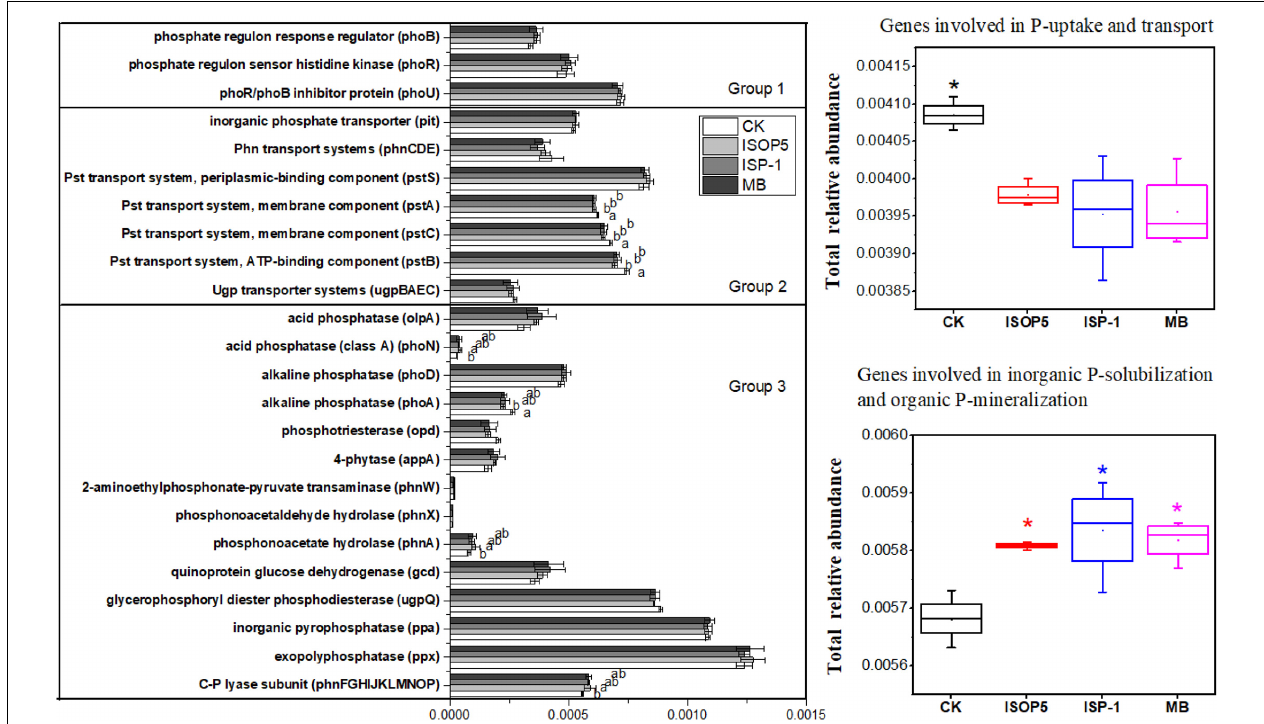
FIGURE 3 | Relative abundance in representative genes responsible for microbial (1) P starvation response regulation, (2) P uptake and transport, and (3) inorganic P solubilization and organic P mineralization in soils treated with or without bacterial inoculums. The relative abundances of genes were calculated based on the annotated reads. Group 1: Genes coding for P starvation response regulation; Group 2: Genes coding for P uptake and transport; Group 3: Genes coding for inorganic P solubilization and organic P mineralization. Different lowercase letters and asterisks represent the significant effects of bacteria inoculums on the relative abundance of genes involved in P transformation at p < 0.05. Error bars are ± standard error. CK: fertilized with basic fertilizer containing NPK fertilizers and composted cow manure; B. cepacia ISOP5: fertilized with basic fertilizer and then applied with suspension of strain B. cepacia ISOP5; R. palustris ISP-1 : fertilized with basic fertilizer and then applied with suspension of strain R. palustris ISP-1; MB: fertilized with basic fertilizer and then applied with suspensions of B. cepacia ISOP5 and R. palustris